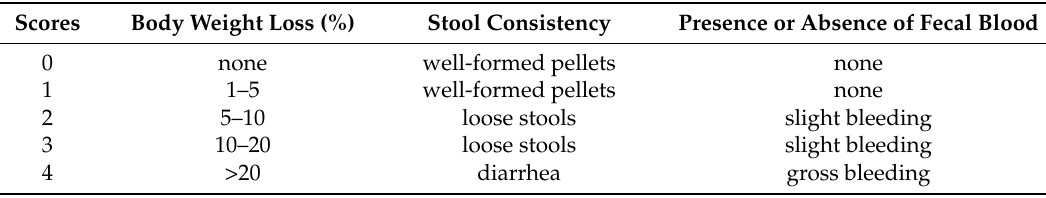
Table 1. Criteria for scoring disease activity index